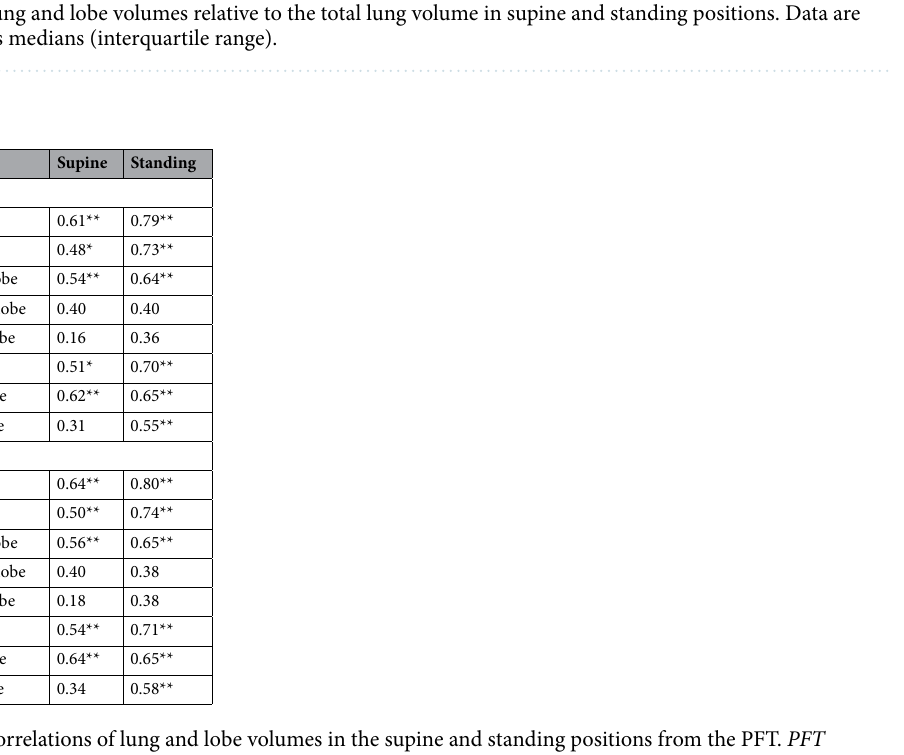
The correlations of lung and lobe volumes in the supine and standing positions with the results of the PFT are shown in Table 4 and Supplementary Figs. S4 and S5. Volumes of the total lung, right lung, right upper lobe, left lung, and left upper lobe in the supine and standing positions were significantly correlated with VC (total lung: ρ = 0.61 vs. ρ = 0.79; right lung: ρ = 0.48 vs. ρ = 0.73; right upper lobe: ρ = 0.54 vs. ρ = 0.64; left lung: ρ = 0.51 vs. ρ = 0.70; left upper lobe: ρ = 0.62 vs. ρ = 0.65, respectively; all p < 0.05) and FVC (total lung: ρ = 0.64 vs. ρ = 0.80; right lung: ρ = 0.50 vs. ρ = 0.74; right upper lobe: ρ = 0.56 vs. ρ = 0.65; left lung: ρ = 0.54 vs. ρ = 0.71; left upper lobe: ρ = 0.64 vs. ρ = 0.65, respectively; all p < 0.05). Left lower lobe volumes in the supine position were